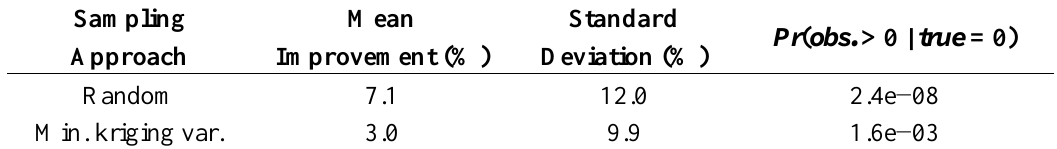
Table 3. EVOI improvements with respect to random sampling and minimisation of kriging